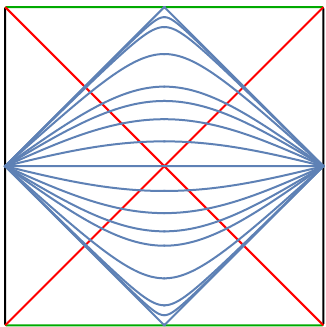
Figure 5. Penrose diagram for (half of) dS 2 and the geodesics in blue connecting t R = t L = 0 . P runs from −∞ to ∞ and in these limits, the geodesics become (almost everywhere)